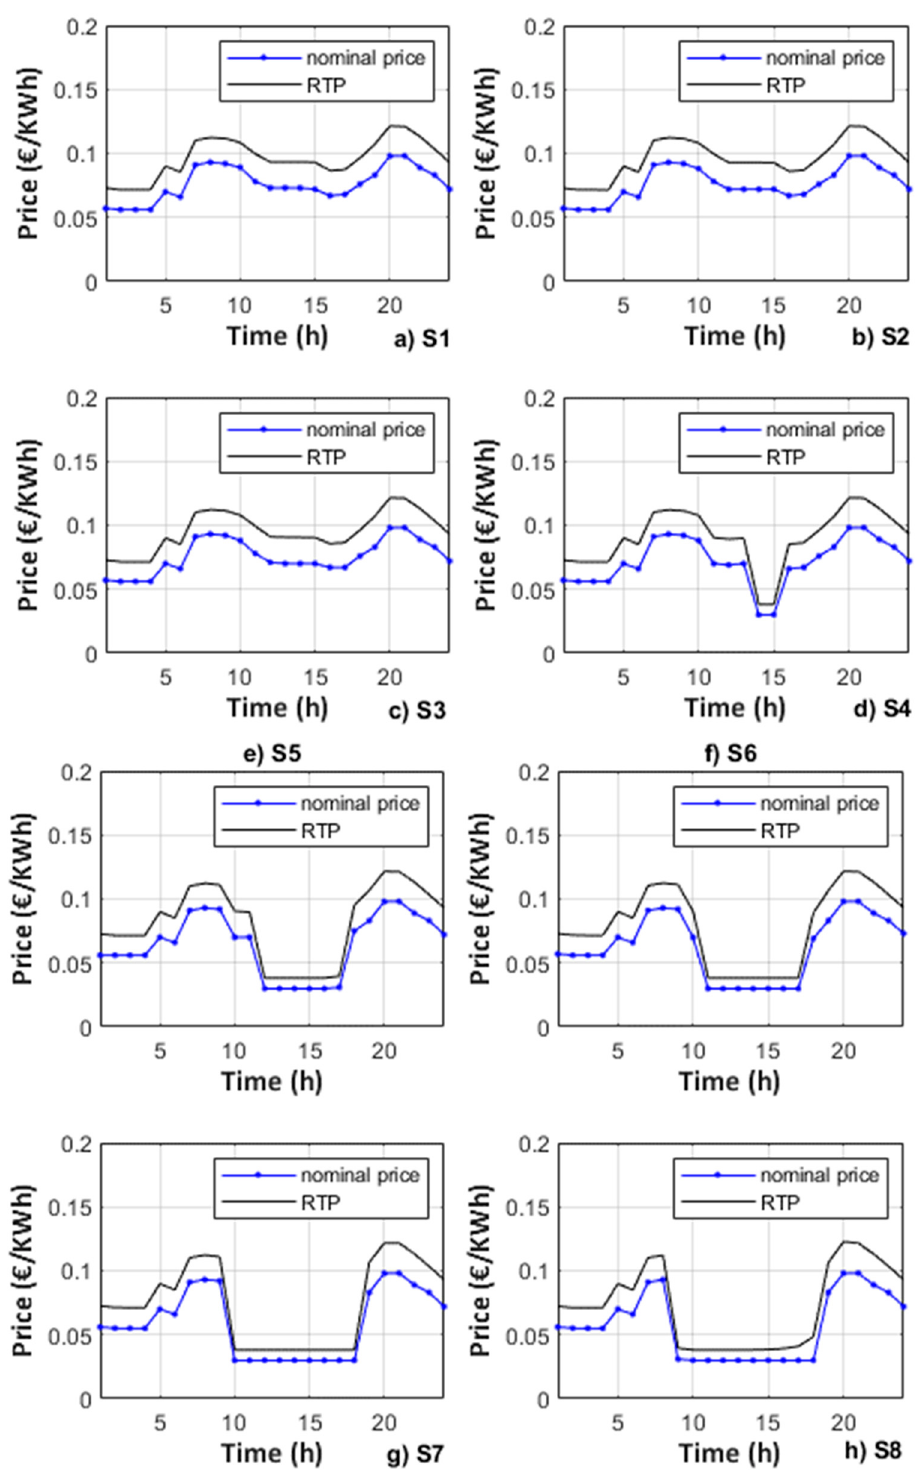
Figure 5. Nominal price and real-time pricing (RTP) corresponding to day 25 April 2019 for: ( a )